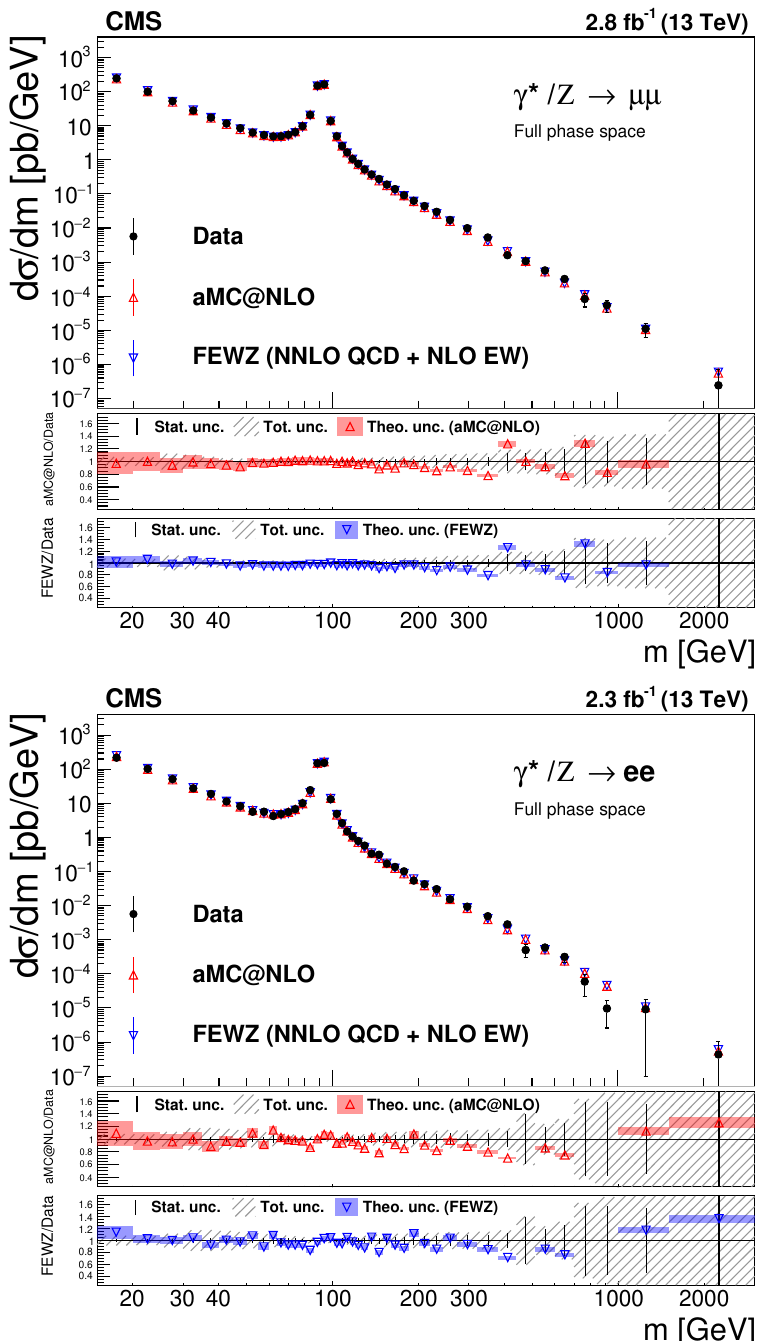
Figure 4 . The di(cid:11)erential cross section as a function of the dimuon (upper) and dielectron (lower) invariant mass, measured in the full phase space, with FSR correction applied. The spectra are compared with the NNLO theoretical prediction of fewz (blue) and the NLO prediction of Mad- Graph 5 a mc@nlo (red). The NNPDF3.0 PDF set is used in both cases. In the middle and lower panels, the coloured bands denote the theoretical uncertainty and the hatched bands denote the total uncertainty, which is the combination of statistical, systematic, and integrated luminosity components.